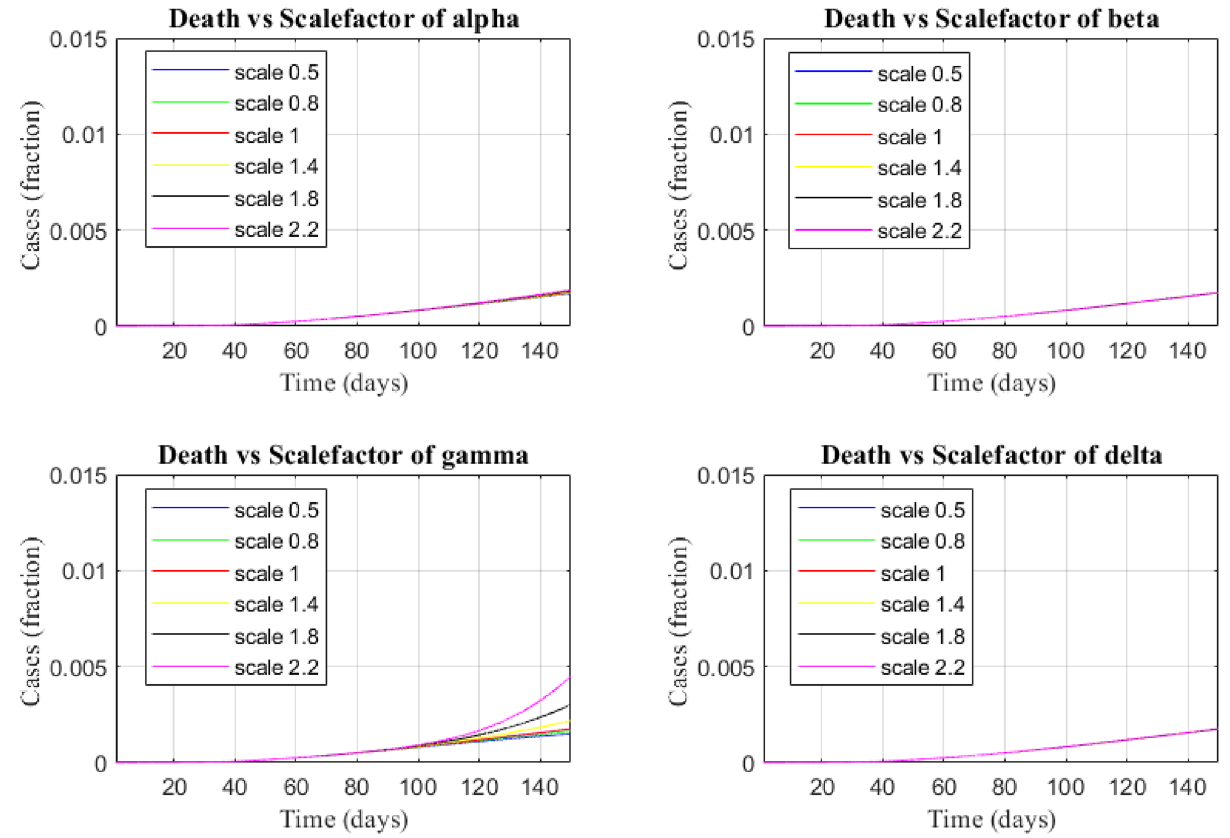
Figure 10. The sensitivity of transmission parameters over death